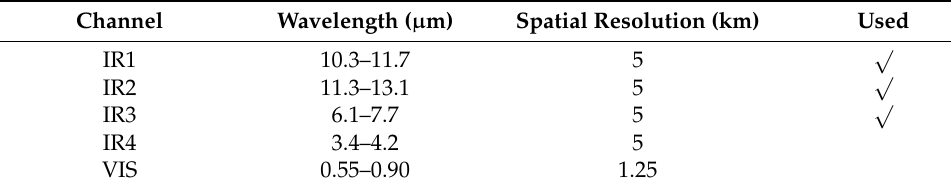
Table 1. FY-2E satellite imager radiometric